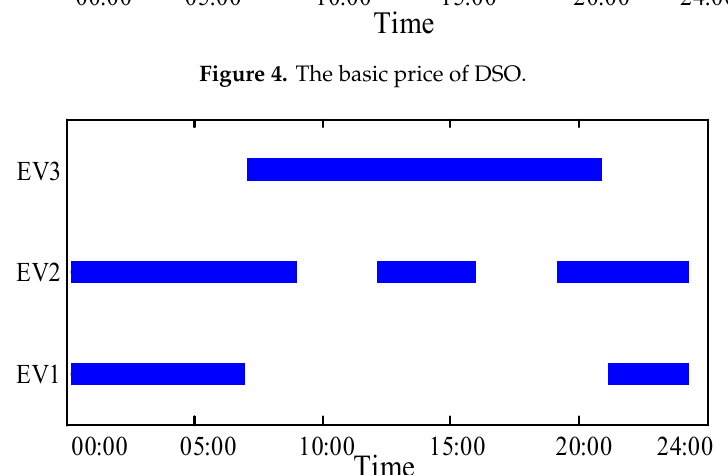
Figure 4. The basic price of DSO.